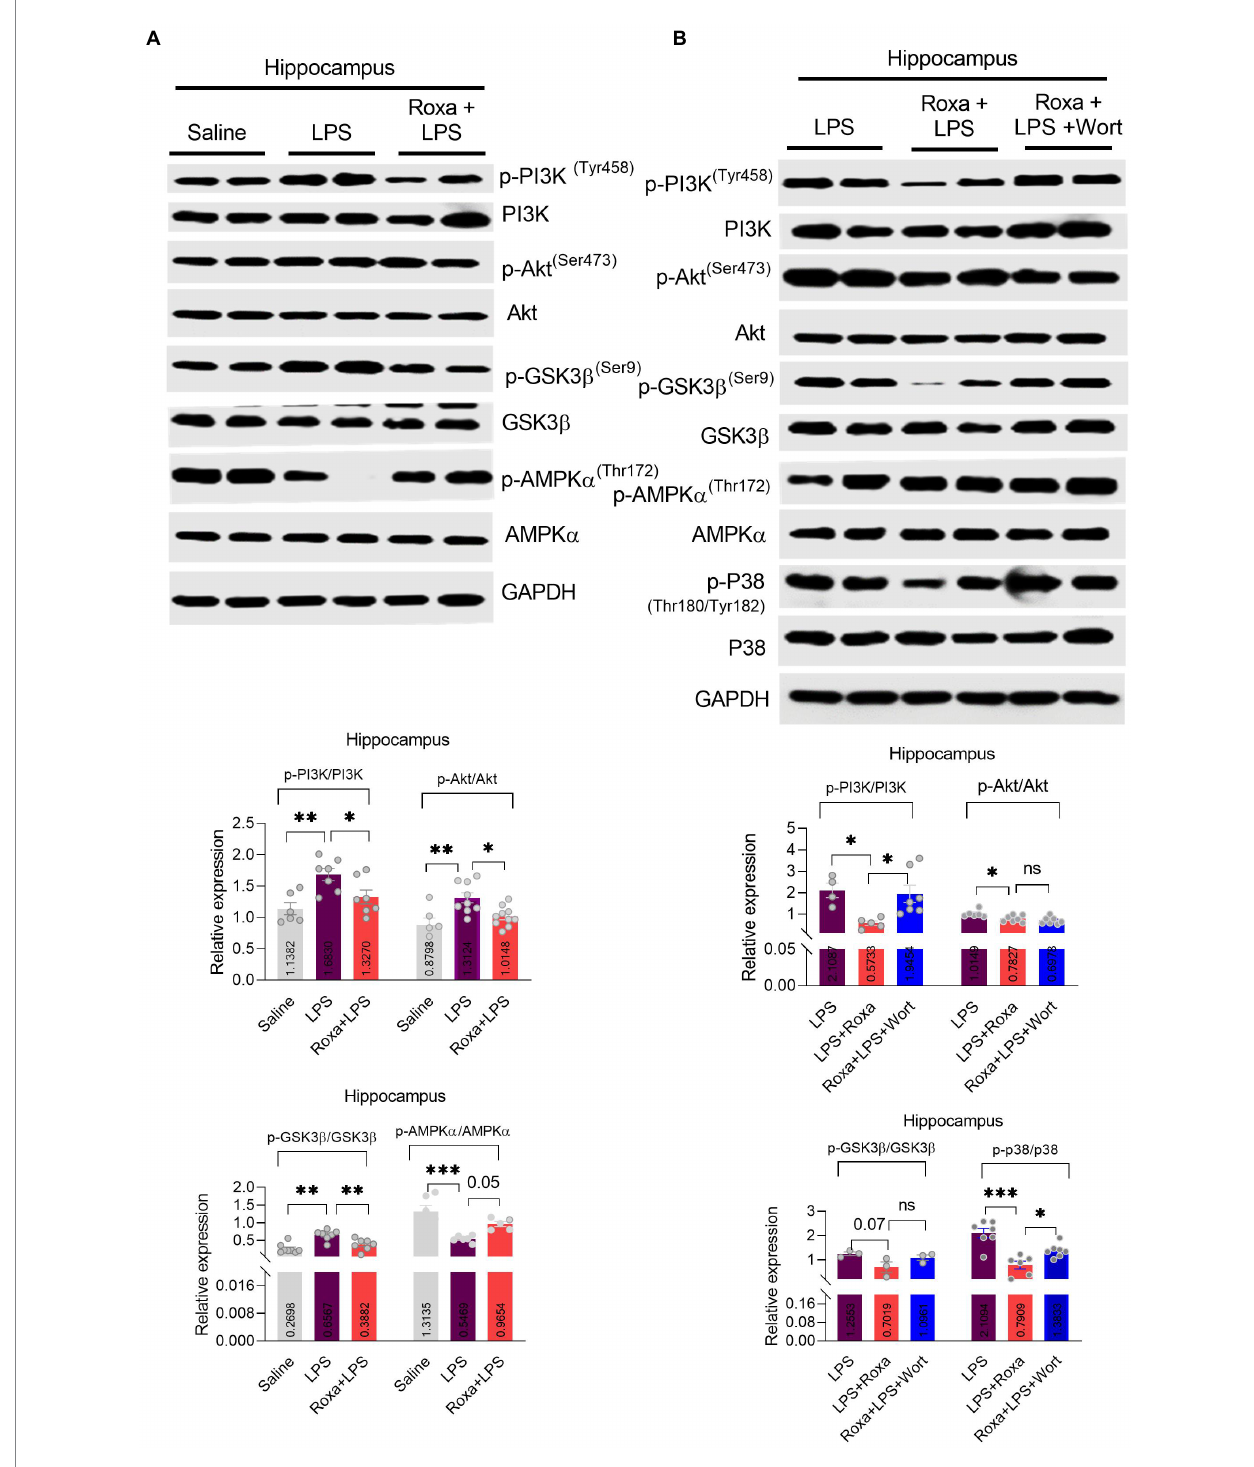
FIGURE 3 Roxadustat reduced LPS-induced PI3K and its associated signaling. ( A,B) representative western blots of PI3K, Akt, GSK3 β , APMK α , and P38 and quantitative column graphs for mice treated with LPS, Roxadustat and wortmannin. All the values were normalized with GAPDH. Image lab software was used for blots quantitative analysis and was analyzed via GraphPad prism. Data were expressed as mean ± SEM, One-way ANOVA, followed by post hoc analysis. p = <0.05 were considered significant. * p < 0.05, ** p < 0.01), *** p < 0.001. ns: